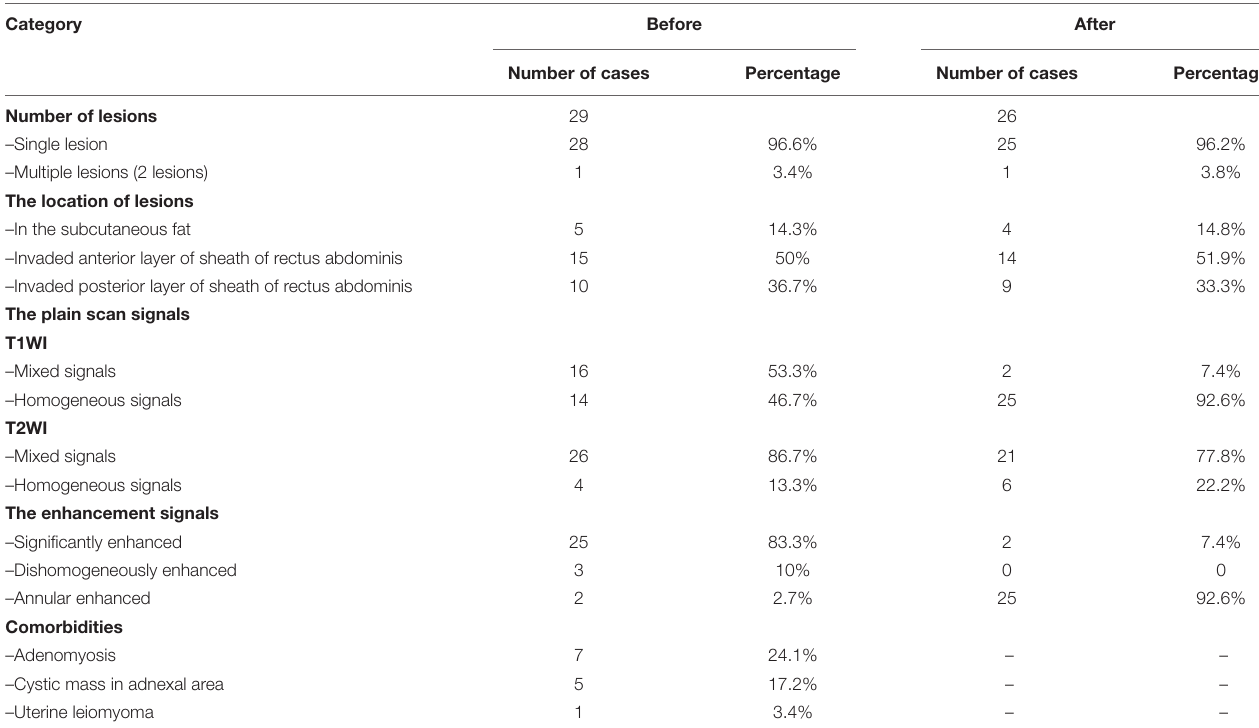
TABLE 4 | MRI characteristics before and after HIFU treatment. Category Before After Number of